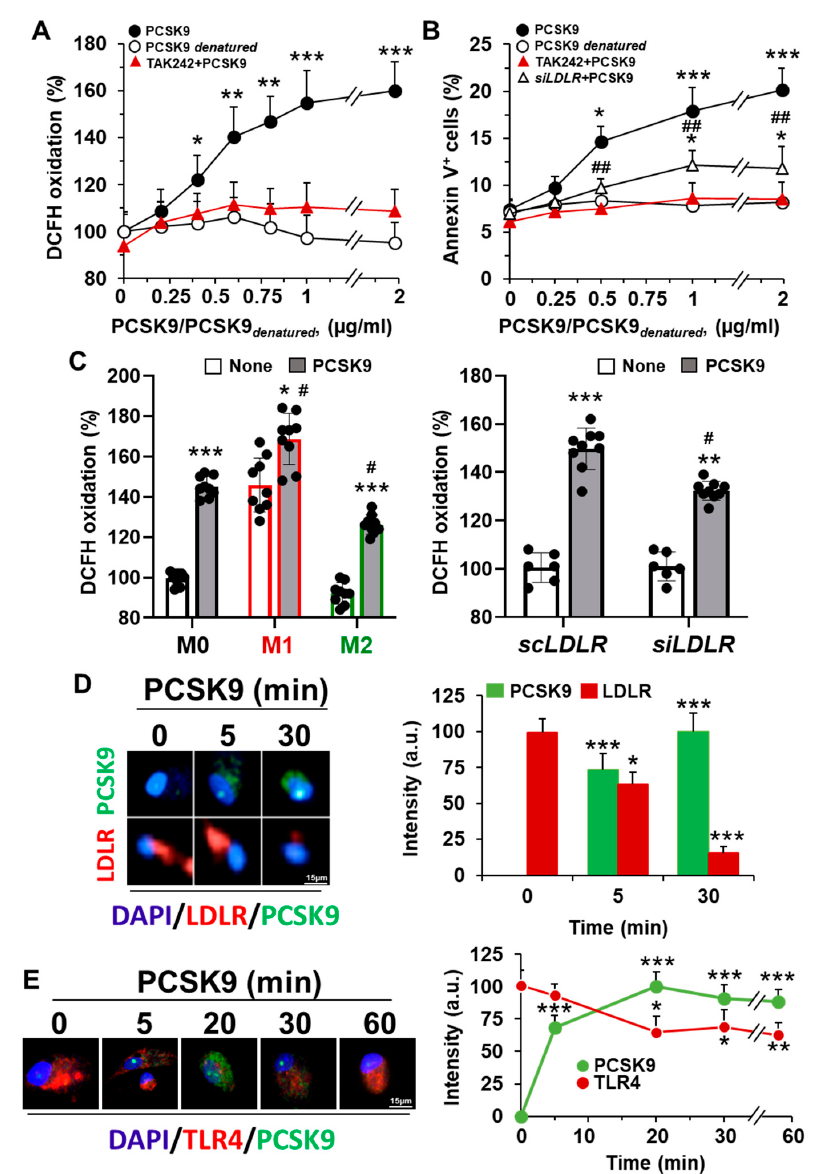
Figure 2. Treatment of human M ϕ with PCSK9 enhances ROS synthesis and induces apoptosis. ( A ) PCSK9 dose-dependent oxidation of DCFH in hM ϕ treated for 18 h with recombinant PCSK9 or heat-inactivated PCSK9 (PCSK9 denatured ). When TLR4 activity was inhibited, cells were treated for 30 min with 1 µ M TAK242 before PCSK9 incubation. ( B ) Apoptosis was evaluated by flow cytometry, quantifying the annexin V + cells. Silencing of LDLR was done as described in the methods Section 4.6; ( C ) ROS production was determined in M0, M1-like, and M2-like polarized hM ϕ treated with the indicated stimuli 18 h before incubation with 1 µ g/mL of PCSK9 for an additional period of 18 h. When LDLR was silenced, the time of incubation with scRNA or siRNA was 48 h before PCSK9 addition to the cell culture. ( D , E ) Representative immunofluorescence images of hM ϕ treated with 1 µ g/mL of human recombinant PCSK9. At the indicated times, cells were fixed and stained with anti-PCSK9 antibody (in green), DAPI (in blue), and an anti-human LDLR antibody ( D ) or anti-human TLR4 antibody (both in red) ( E ). Data show the mean ± SD of 4 independent experiments. * p < 0.05, ** p < 0.005, and *** p < 0.001 vs. the control condition ( A , B ), vs. the corresponding vehicle condition for TAK242 ( C ), and vs. the value at time 0 ( D , E ), respectively. # p < 0.05 and ## p < 0.005 vs. the corresponding siLDLR condition and vs. the M0 or the scLDLR condition ( C ),